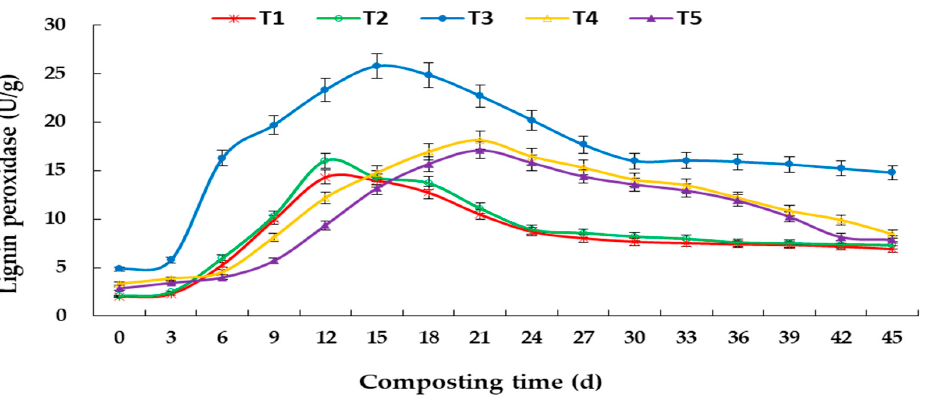
Figure 6. Changes of lignin peroxidase activity during composting of corn straw and cow dung under different C/N ratios.